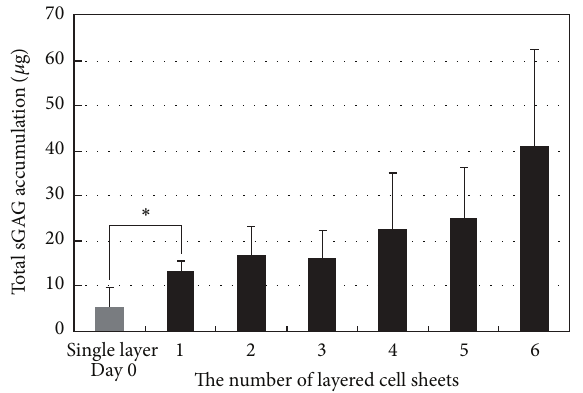
Figure 4: Detection of sulfated glycosaminoglycan (sGAG) accu- mulation within layered cell sheets at 24 h after the start of cultiva- tion.Withincreasingthenumberofstratifiedcellsheets(fromsingle to sextuple), sGAG accumulation increased. Data are shown as the mean ± SD ( 𝑛 = 3 ). The sGAG accumulations within a cell sheet enhanced during 24-h cultivation after detachment ( ∗ 𝑃 < 0.05